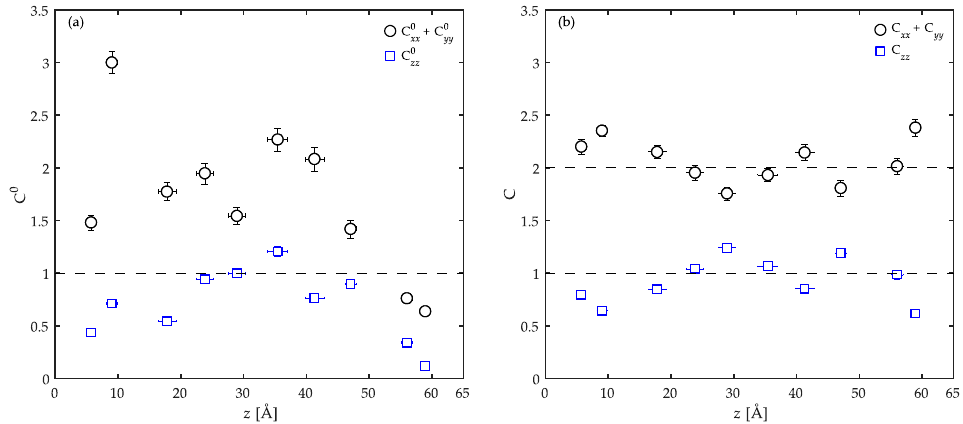
Figure 8. The overall alignment of PP chains along the thickness of the film either parallel ( C xx0 + C yy0 ) or normal ( C zz0 ) to the substrates expressed utilizing the concept of the conformation tensor. The results in ( a ) are calculated based on Equation (5); in ( b ), Equation (5) was reduced by the end-to-end distance of each confined chain instead of the averaged end-to-end distance of the unperturbed chains. Therefore, the ‘0’ superscript was removed from the notations of the conformation tensor and its components to emphasize this distinction. The data are calculated for each chain individually and are plotted as a function of the z coordinate of the center of mass of that respective chain. Note that the horizontal error bars are multiplied by a factor of 10 to increase their visibility. The results are calculated for the confined PP/Fe 2 O 3 system at 458 K and 1 atm.